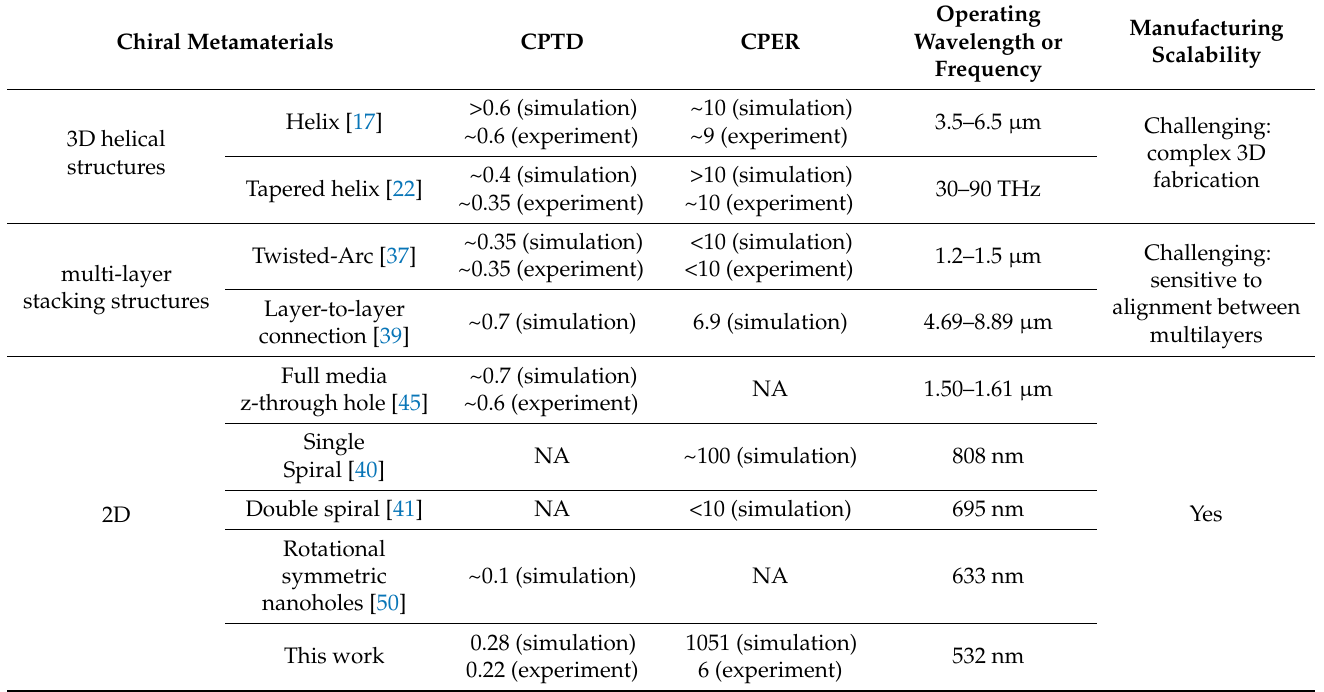
Table 1. Comparison of chiral